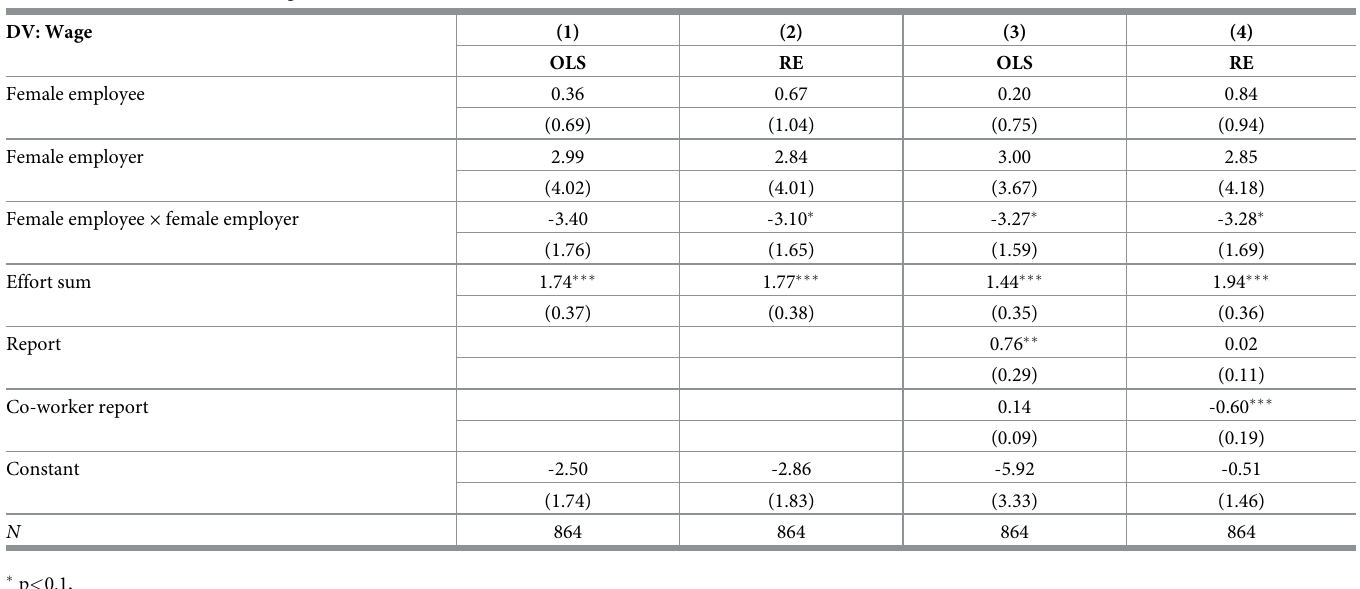
Table 5. Gender discrimination regressions in treatment SRG